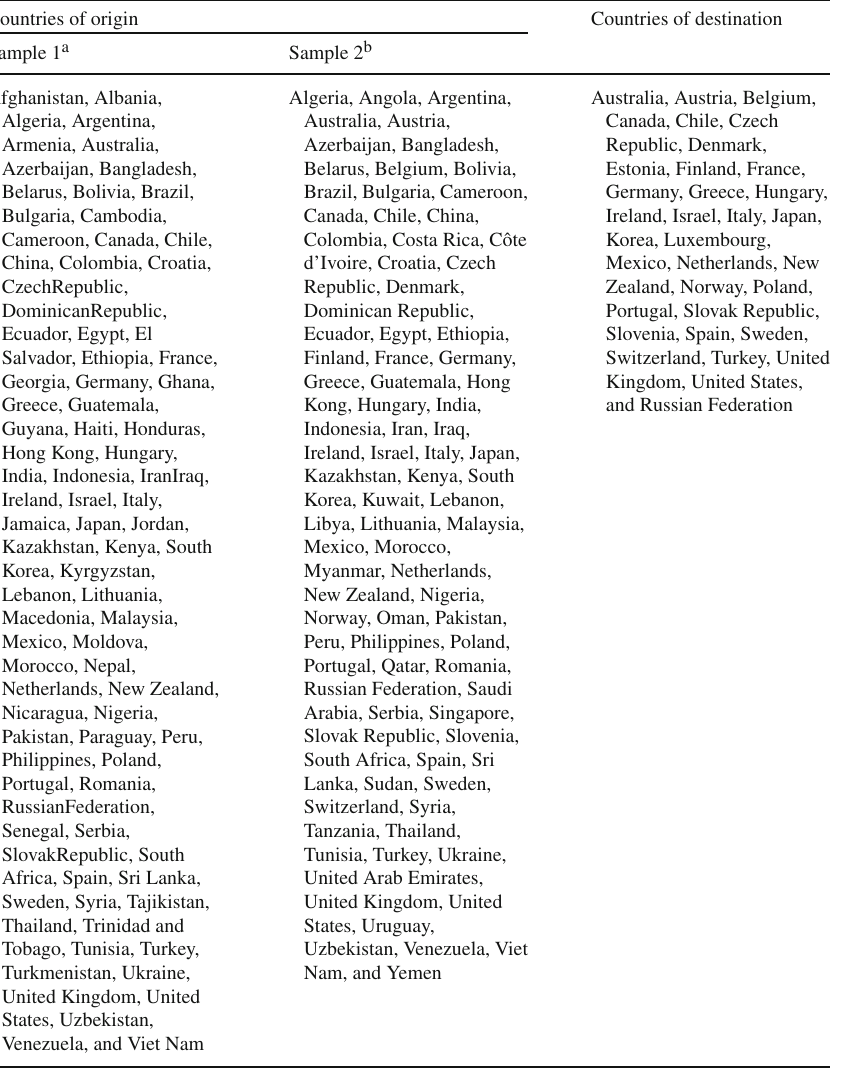
Table 3 Countries used in the samples Countries of